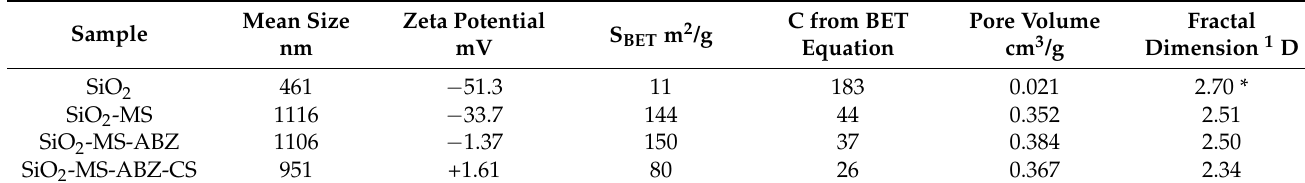
Figure 4. ( a ) N 2 adsorption-desorption isotherms at 77 K of the unmodified and modified silica nanoparticles; ( b ) pore size distribution estimated by BJH method from adsorption branch (except for SiO 2 -MS-ABZ-CS sample, where desorption branch was used for calculations); ( c ) pore width estimated by NLDFT from adsorption branches and assuming cylindric pores. Table 1. Parameters of the nanoparticles estimated by dynamic light scattering, electrophoretic light scattering, and nitrogen